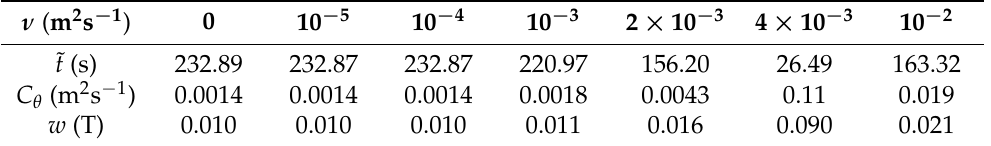
Figure 3. Depiction of two possible solutions for the problem with parameters ν = 10 − 4 m 2 s − 1 , √ √ ρ 0 = 2 2 m, ρ T = 2 m, θ 0 = θ T = π /4, k = 1 m 2 s − 1 and T = 250 s. The solution depicted by the blue line is optimal since it has a lower energy cost ( w ( T )) ≈ 0.01) than the one depicted in red ( w ( T )) ≈ 0.07). Both of these candidates arose from applying the maximum principle to the problem. Table 2. Values of the parameters and energy costs for the optimal solutions of the problem with √ √ ρ 0 = 2 2 m, ρ T = 2 m, θ 0 = θ T = π /4, k = 1 m 2 s − 1 and T = 250 s for various kinematic viscosities. The ν = 0 scenario is presented for comparison, and the values of the parameters were calculated analytically from Marques et al.